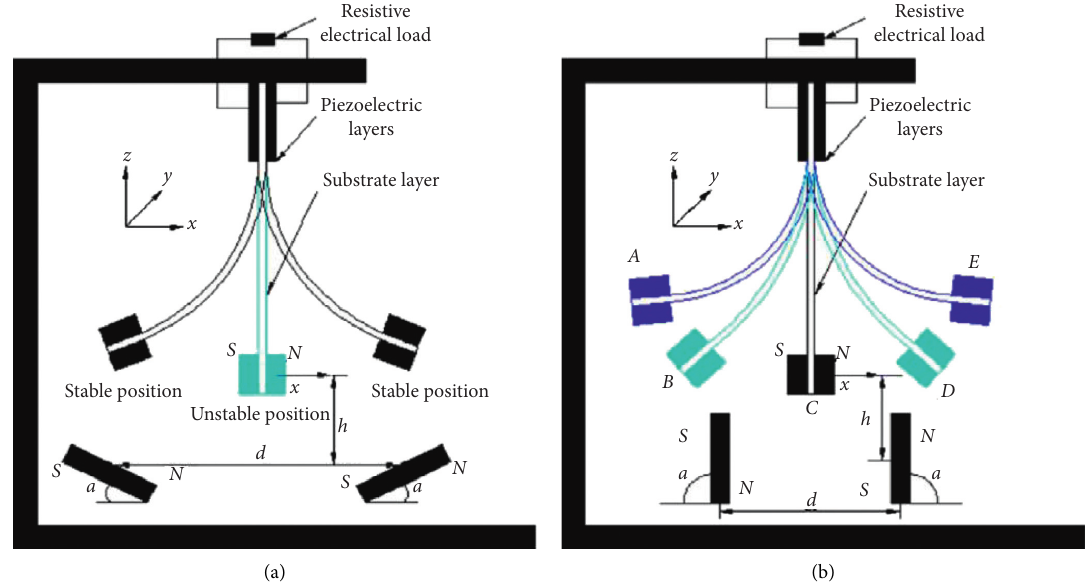
Figure 20: Nonlinear energy harvesting system. (a) Bistable. (b) Tristable